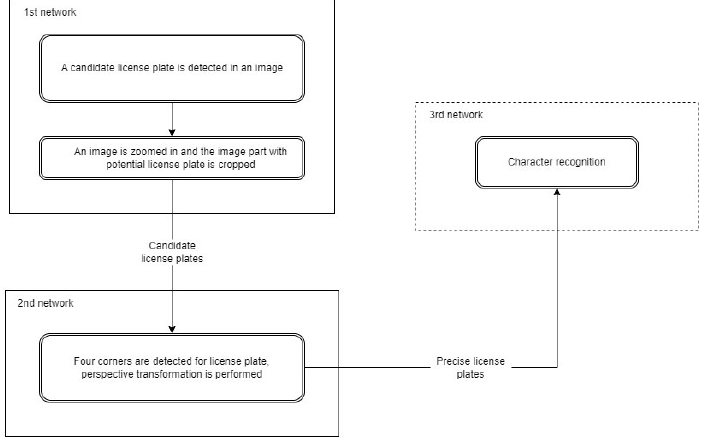
Figure 1. Proposed two-step license plate recognition algorithm: the first network filters out candidate license plates, while the second network detects precise license plates. The final output is a clear image of only the license plate, which can then be used for the next step: character recognition. The goal of this work is to improve the license plate detection algorithm.